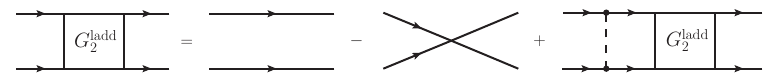
Figure 2. Ladder approximation G ladder